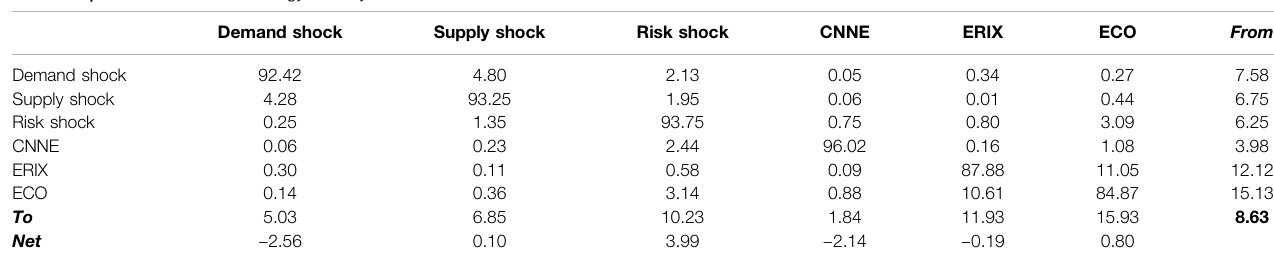
TABLE 4 | Oil shocks and new energy volatility connectedness